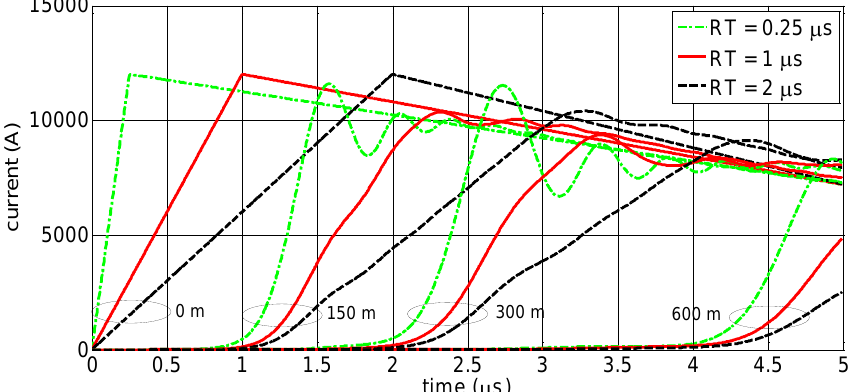
Figure 10. Current distribution along the lightning channel at different heights calculated by CST-MWS for L = 4 μH/m and R = 1 Ω/m for channel length = 0–500 m, R = 6 Ω/m for channel length = 500–2000 m, RT = 0.25 μs, RT = 1.0 μs, and, RT = 2.0 μs. Model C : Wire in free-space loaded by distributed series inductance. Ellipses in the plot are used to link together the curves corresponding to each height along the channel.